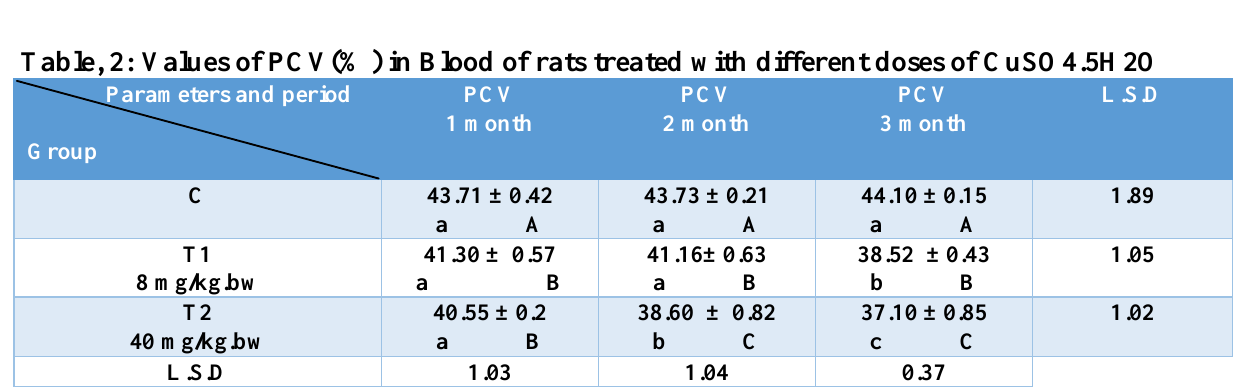
Different small letters means significant (P<0.05) results within groups VS Different big letters means significant (P<0.05) results between groups VS. control